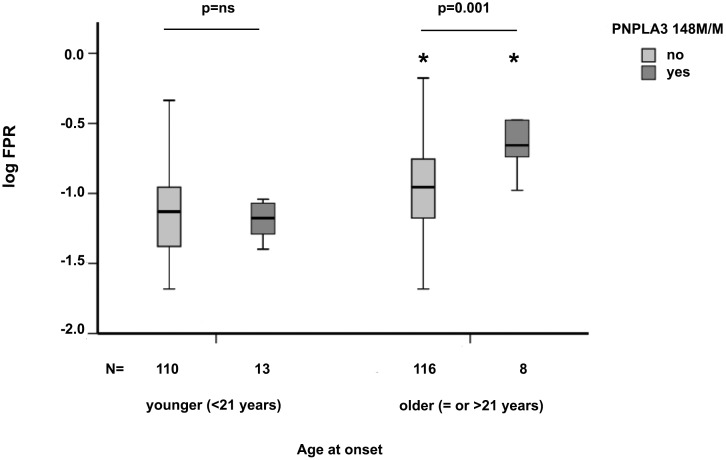
Fibrosis progression rate (FPR) according to age at infection (> or ≤21 years, median value) and PNPLA3 148M/M status in 247 patients with chronic hepatitis C.Box plots indicate median value and interquatile ranges, whiskers the 5th and 95th centiles. p = 0.001 for faster FPR in PNPLA3 148M/M positive vs. negative patients with older age at infection (>21 years). *p<0.0001 vs. patients with same PNPLA3 148M/M status and younger age at infection (≤21 years).